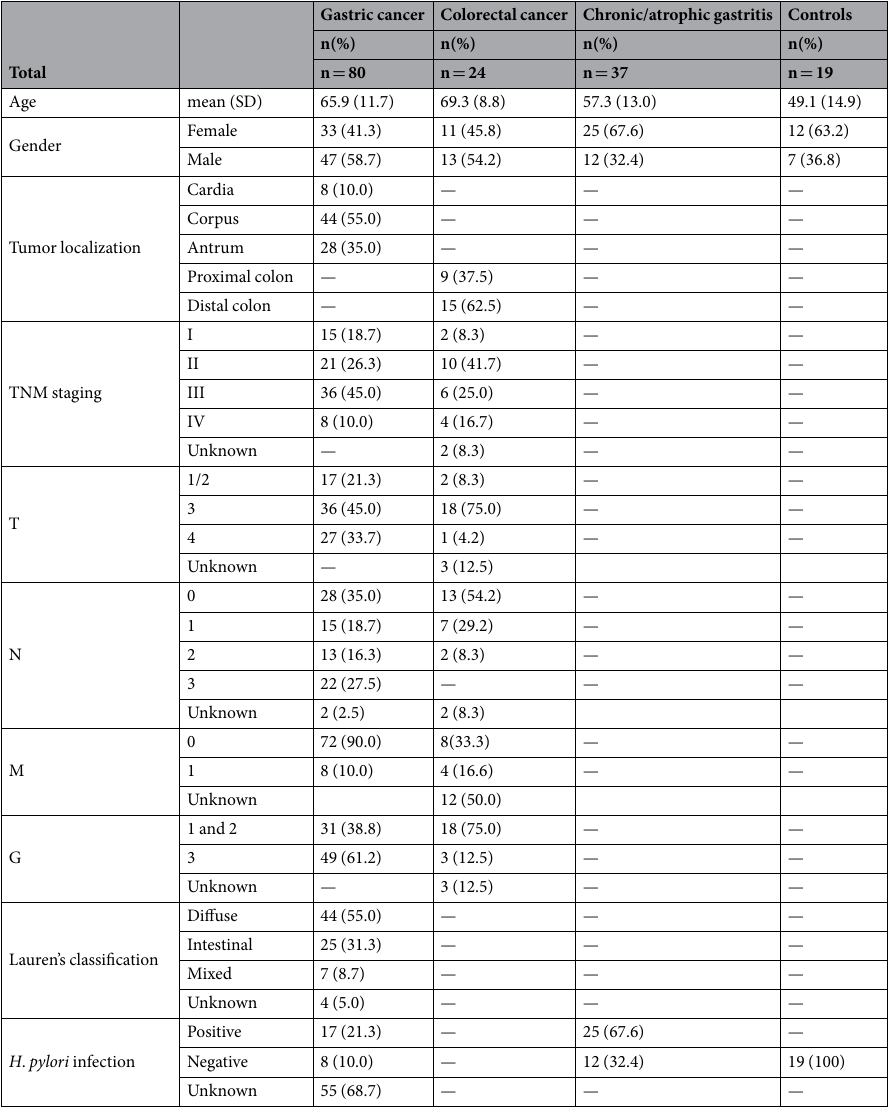
Table 1. Characteristics of patients included in the LINE-1 methylation analysis: controls, gastritis, gastric cancer and colorectal cancer